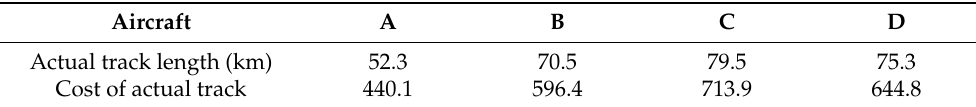
Table 4. Actual track lengths and costs for four aircrafts.